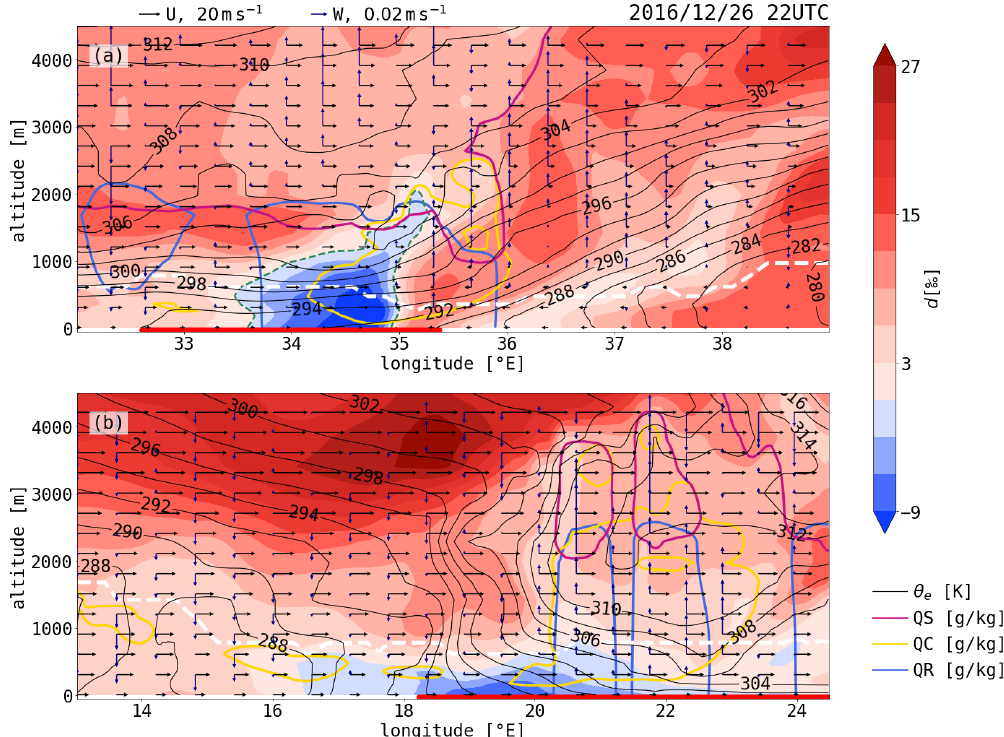
Figure 8. Vertical cross sections of d across the (a) warm front and (b) cold front at 22:00UTC on 26 December 2016. The equivalent potential temperature ( θ e , black contours), the snow water content (QS, pink frame), the cloud water content above 0.1gkg − 1 (QC, yellow frame), the rain water content above 0.005gkg − 1 (QR, blue frame), the boundary layer height (white, dashed line), and horizontal ( U , black) and vertical ( W , blue) wind vectors are shown. The red lines at the bottom of the panels show the regions of warm temperature advection. The orientation of the cross sections is shown in Fig.